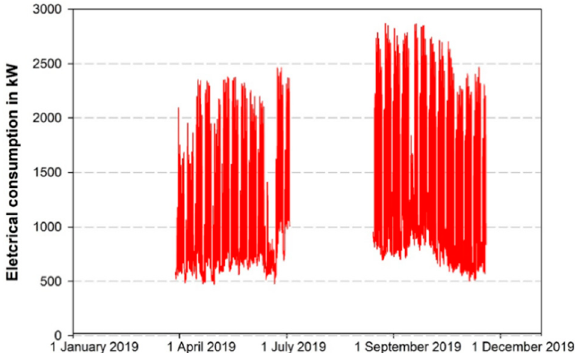
Figure 5. Measured smart meter electrical consumption and data gaps in 2019. Data were only available for 6 months (see text).